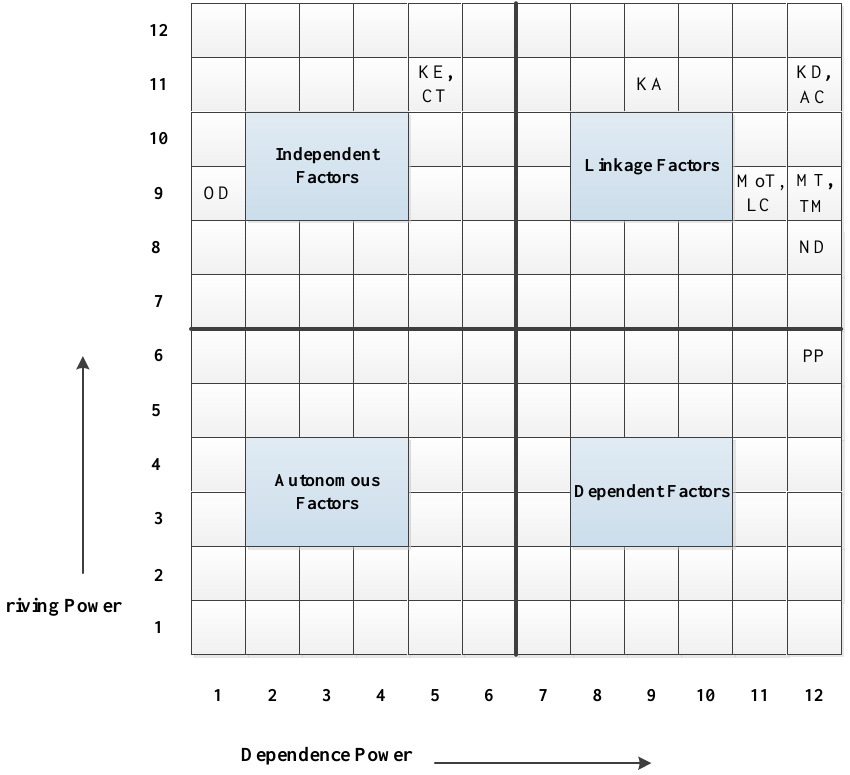
Fig. 5. Driving Power and Dependence Power